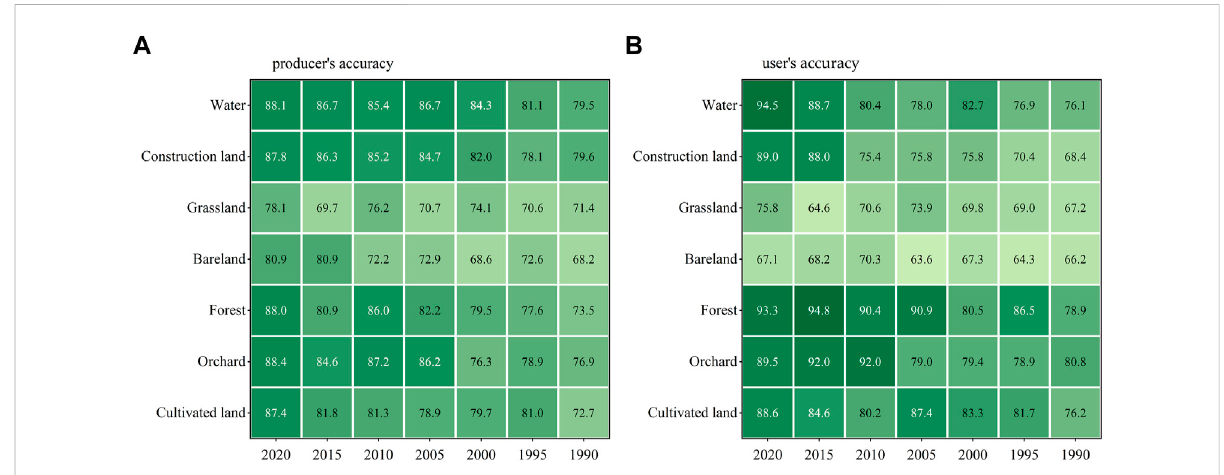
FIGURE 5 Accuracy veri fi cation of land use/cover classi fi cation from 1990 to 2020. (A) Producer ’ s accuracy; (B) user ’ s